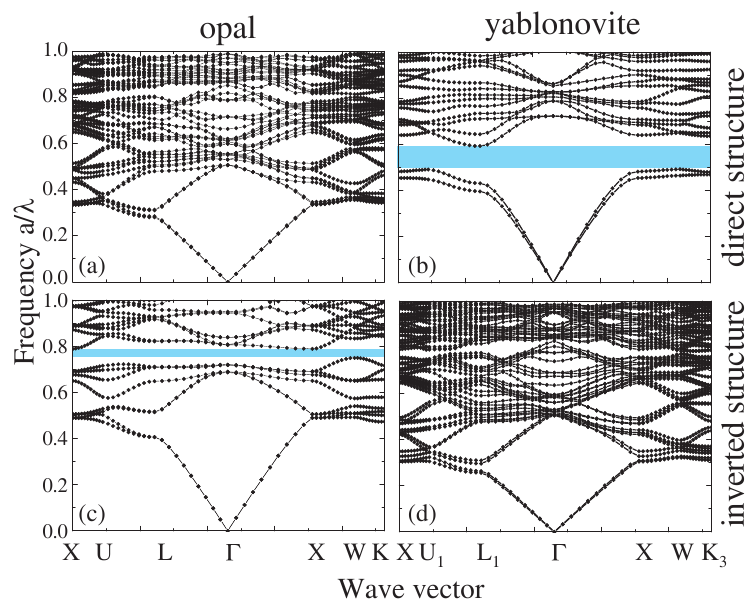
Figure 4. Photonic band structure for ( a ) direct opal; ( b ) directed yablonovite; ( c ) inverted opal and ( d ) inverted yablonovite. The calculations were performed for materials with the relative permittivity ε = 13 in the air surrounding it. Wave vectors are given for a region of the irreducible Brillouin zone, which includes the edges of the complete photonic band gap of the discussed structures. The regions of the complete photonic band gap are marked with blue.